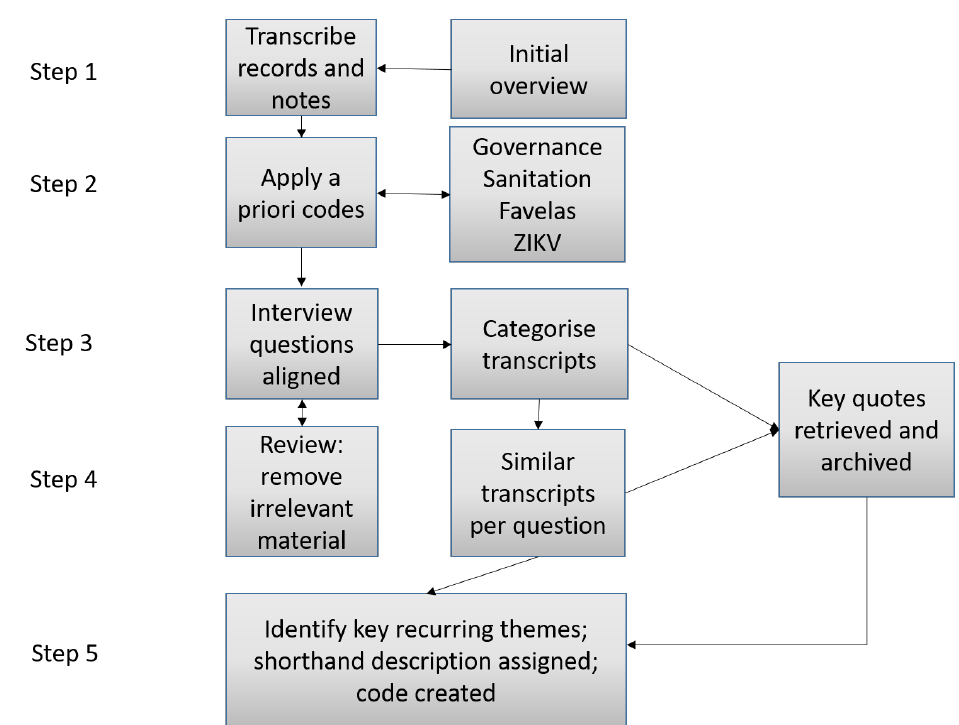
Figure 2. Steps followed in Template Analysis to analyse results of interviews.